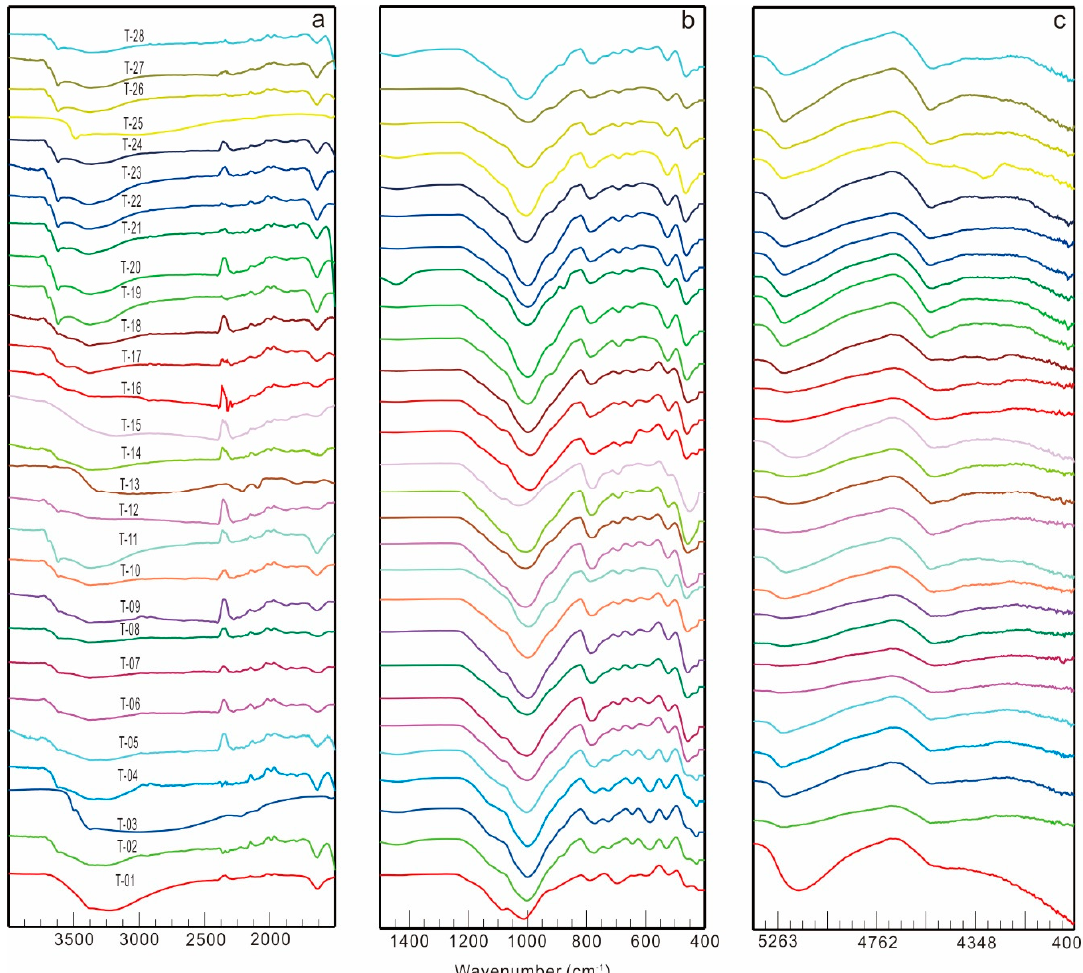
Figure 3. The MIR and NIR spectra of the soil samples: ( a ) shows the MIR spectra from 4000 to 1500 cm -1 , ( b ) shows the MIR spectra from 400 to 1500 cm -1 , and ( c ) shows the NIR spectra from 5405 to 4000 cm -1 . Table 2. Assignment of the MIR absorptions in former